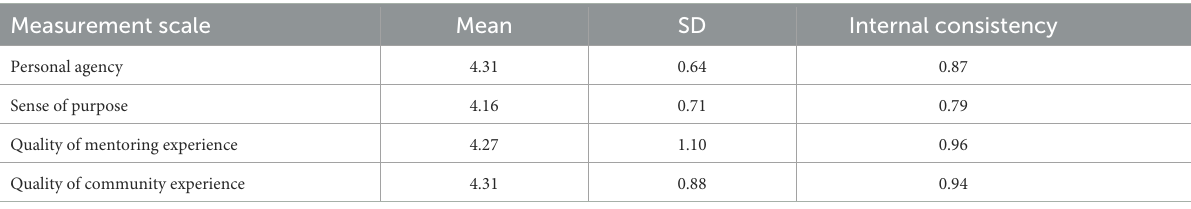
TABLE 5 Means, standard deviation, and internal consistency for measures in the study.